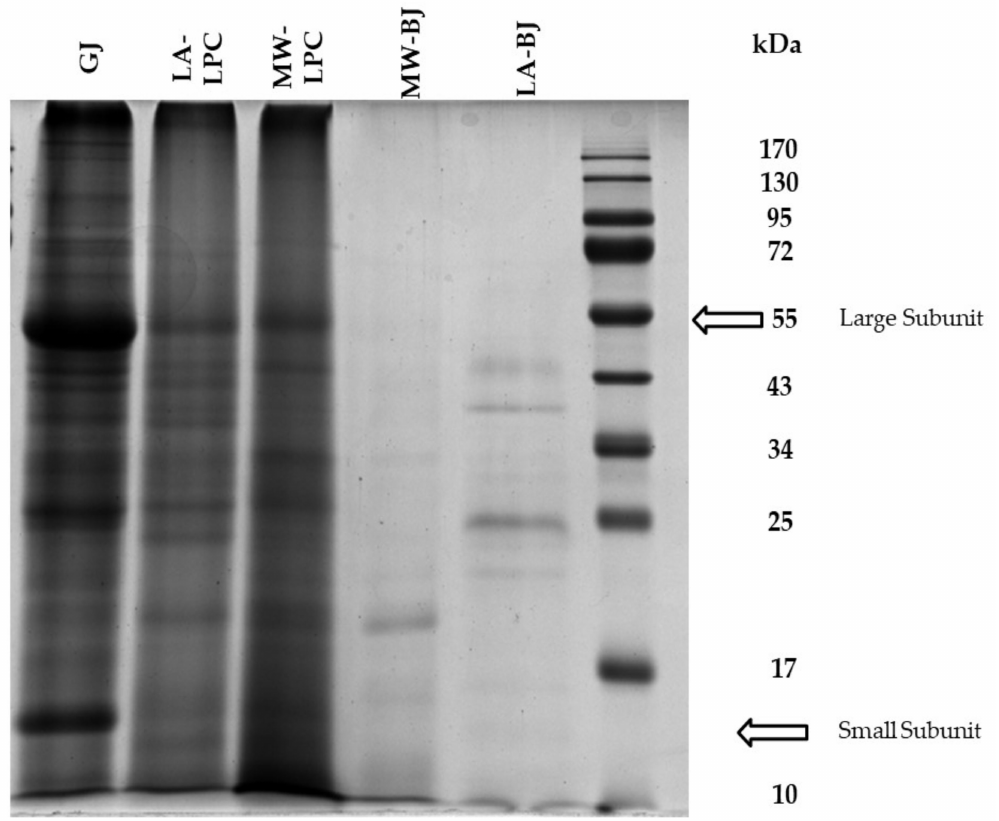
Figure 5. SDS-PAGE analysis of broccoli green leaves-derived fractions by different processes ( Process 1; Process 2 and Process 3 ): freeze-dried green juice (GJ); leaf protein concentrate obtained by microwave coagulation (MW-LPC); leaf protein concentrate obtained by lactic acid fermentation (LA-LPC); brown juice obtained by microwave coagulation (MW-BJ); and brown juice obtained by lacto-fermentation